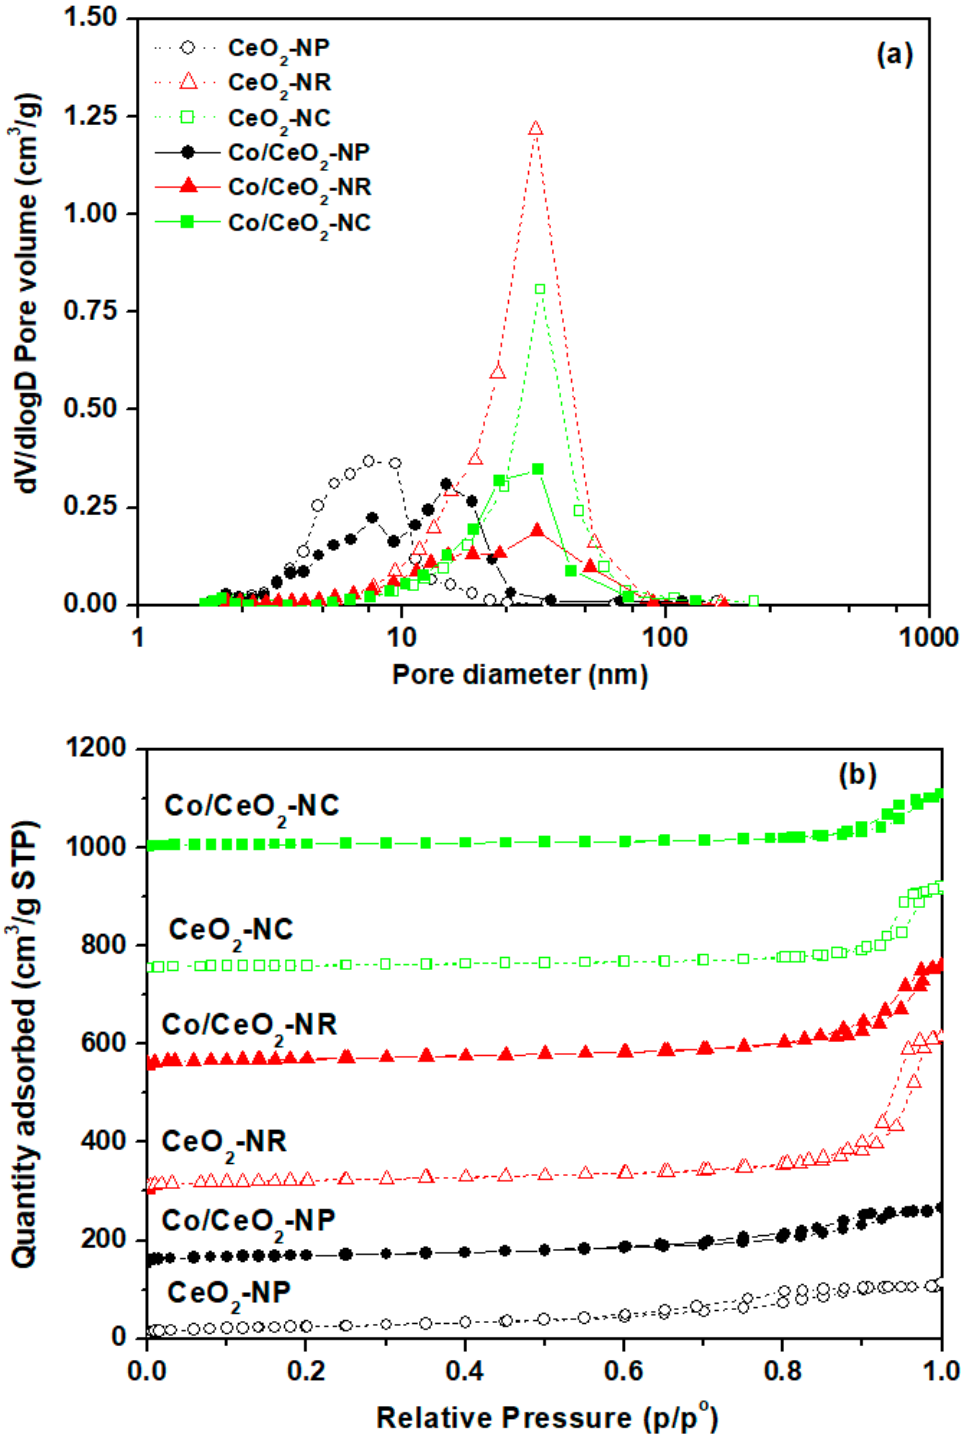
Figure 1. ( a ) The BJH (Barret-Joyner-Halenda) desorption pore size distribution (PSD) and ( b ) the adsorption–desorption isotherms of CeO 2 and Co/CeO 2 samples.